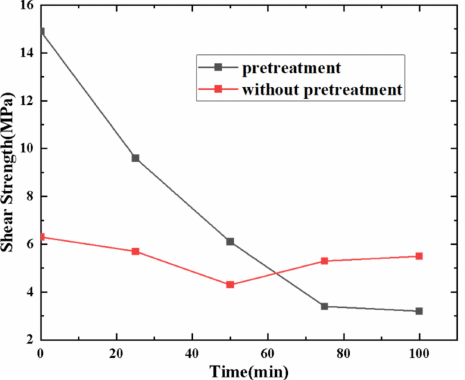
Figure 7. Bonding strength of samples with standing time.